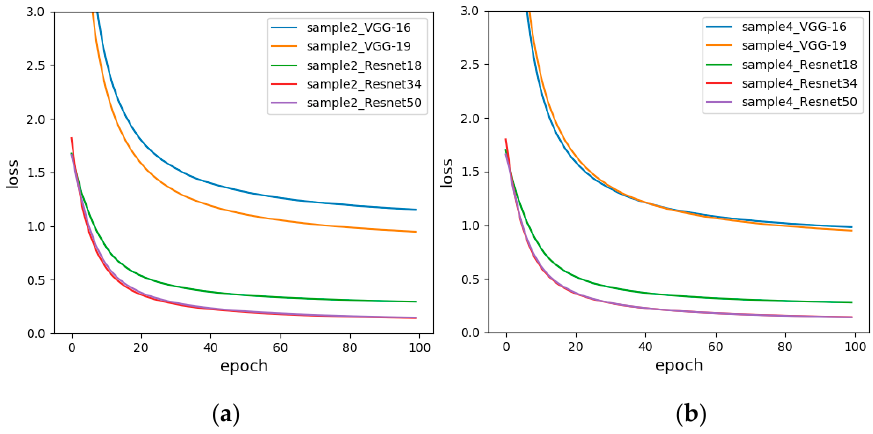
Figure 13. The loss functions of changing the data arrangement direction ( a ) Horizontal arrangement of data (Sample-set 2); ( b ) Vertical arrangement of data (Sample-set 4).